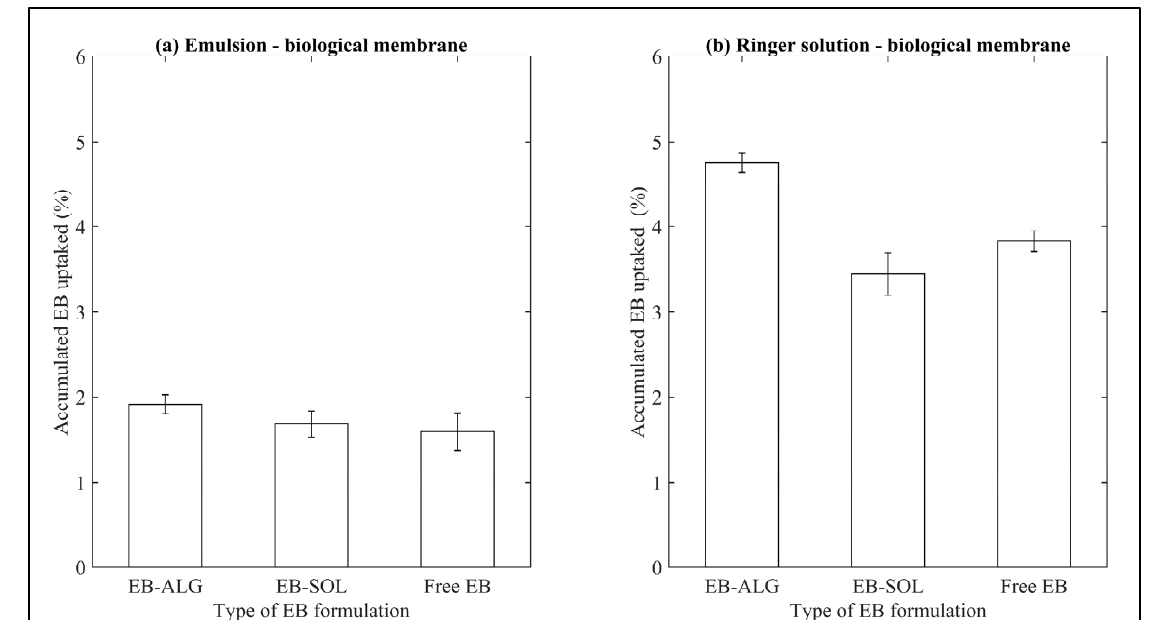
Figure 8. Results of accumulated EB uptake in biological membranes. ( a ) Represents the EB uptake in emulsion as donor media, and ( b ) represents the EB uptake in Ringer solution as donor media. Values represent the mean with standard deviation of five replicates.